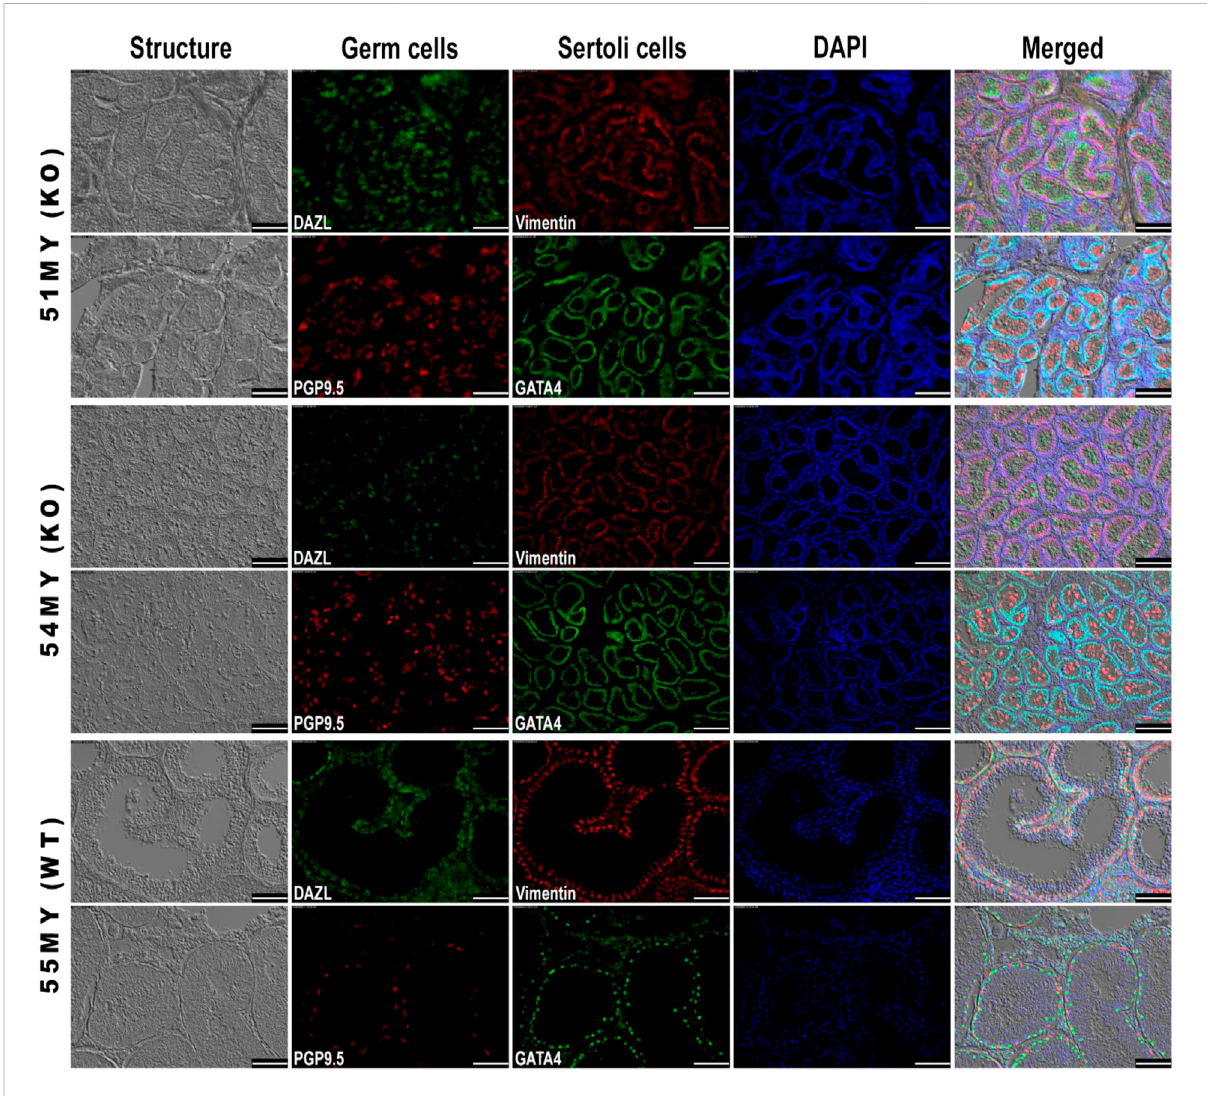
FIGURE 3 Immunohistochemical analysis of germ and Sertoli cell markers in seminiferous tubules from WT and KISS1 KO pigs. Boars were 8 months old. DAPIwasappliedasnuclearstainingandisrepresentedinblue fl uorescence.Combinedimagesofstructure,targetedproteins,andnucleiareshown in the last column. Scale bar = 100